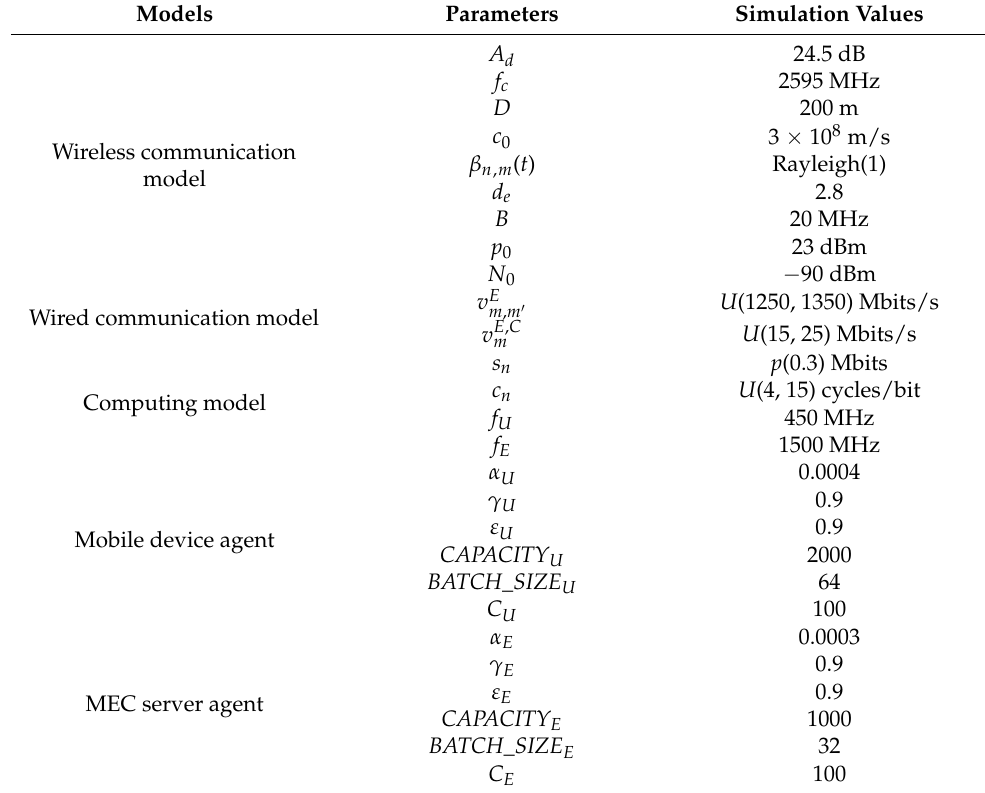
Table 3. All model parameters and simulation